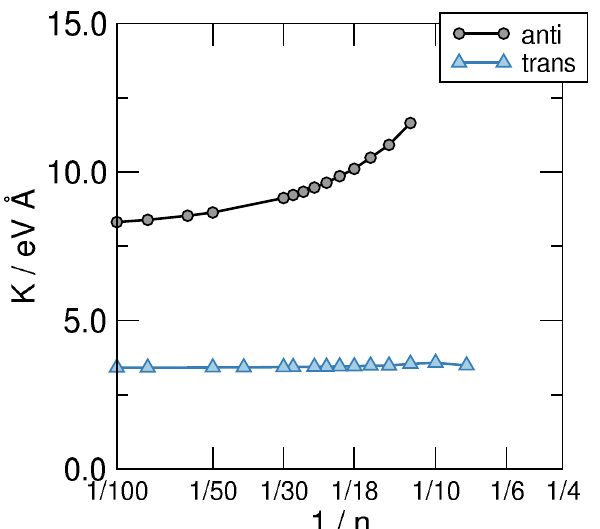
Figure 7. Bending stiffness of the structural sequences defined in Figure 5, on a linear-log